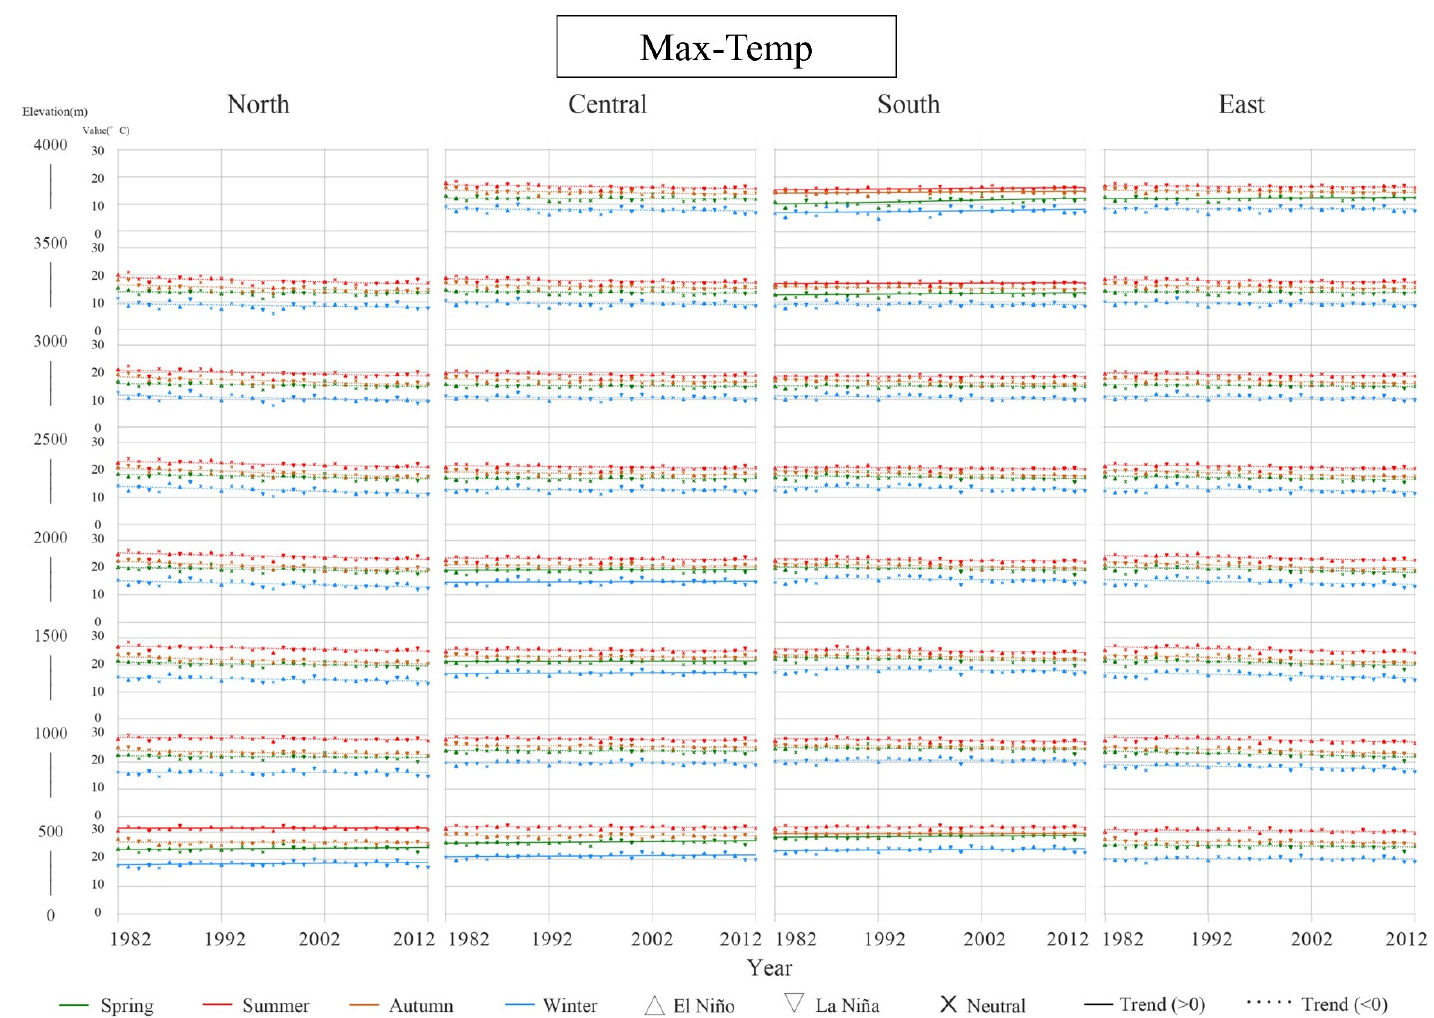
Figure 12. Regional and seasonal linear regression results for the maximum temperature at varied elevations.